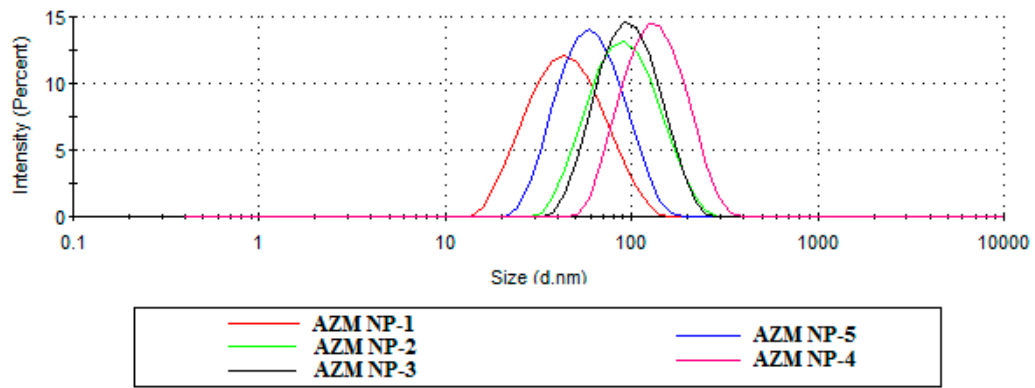
Figure 2. Particle size distribution of Eudragit ® L100 nanoparticles by Malvern Zetasizer.